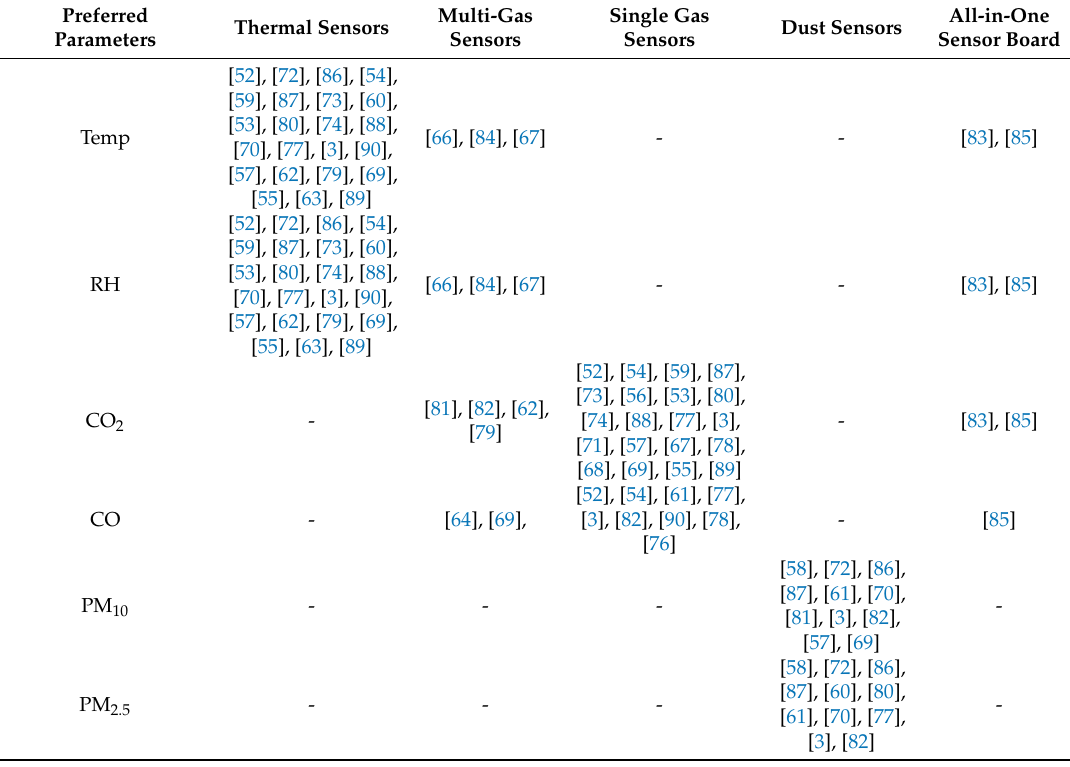
Table 3. IAQ sensors and relevant parameters discussed in existing